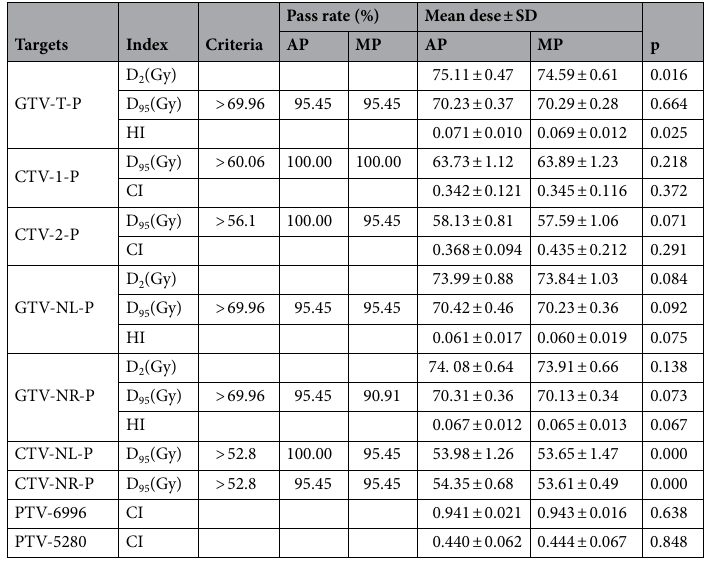
Table 4. Dosimetric comparison of PTVs in manual and automatic VMAT (mean ± SD).